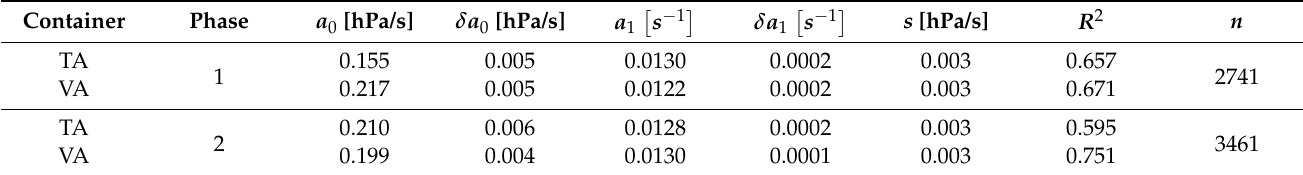
Table A6. Fit parameters for the linear model α ( ∆ e (cid:48) w ) according to Equation (22) for Experiment 3, fitted to the measurements taken in the various containers and experimental phases ( δ —standard error, s —standard deviation of residuals, R 2 —squared correlation coefficient, n —number of